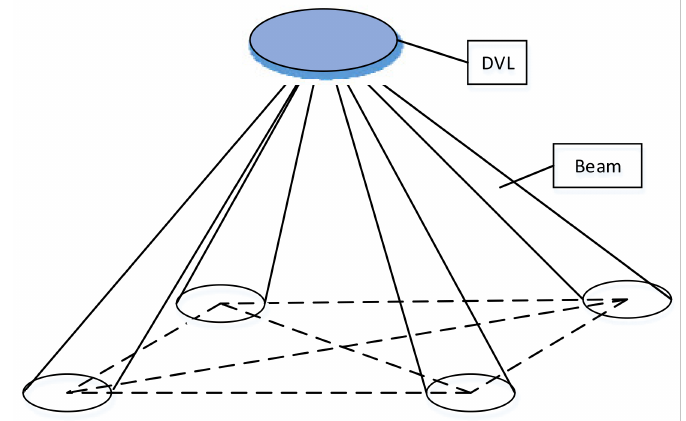
Figure 12. Four-beam Janus configuration